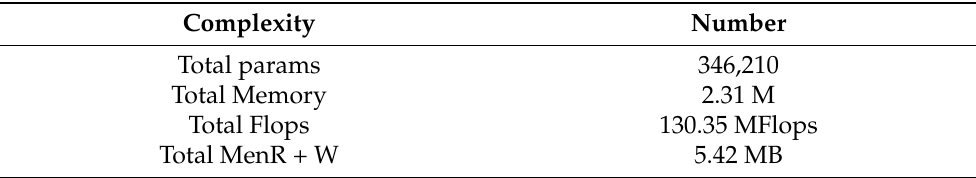
Table 10. Certification effect of the three methods after training on different number of